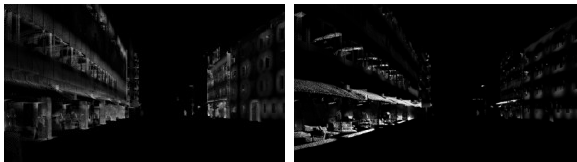
Figure 2. Image of the curvature value (left) and normal vector component in z direction